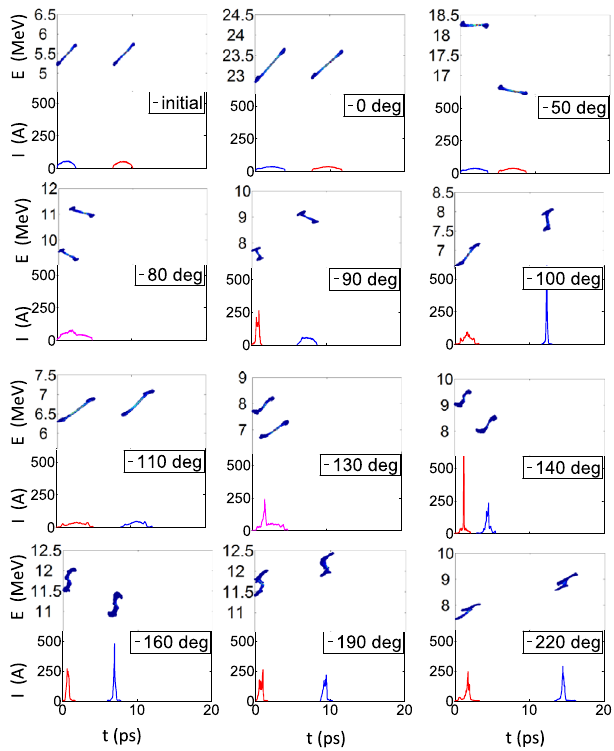
FIG. 7. ASTRA simulations of the longitudinal distributions and phase spaces for two-bunch compression with different injected phases ϕ 0 .